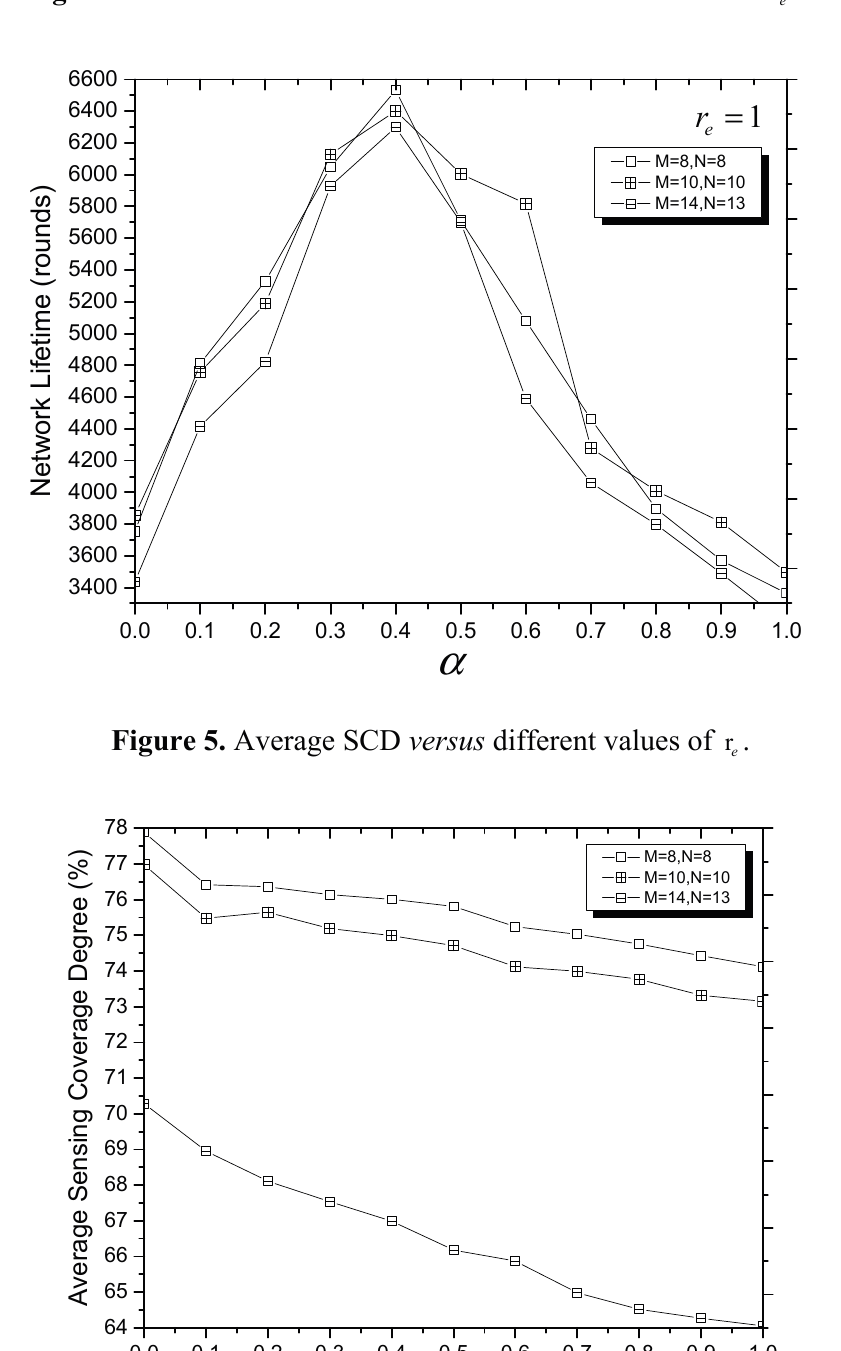
Figure 4. Network lifetime versus different values of α with r 1